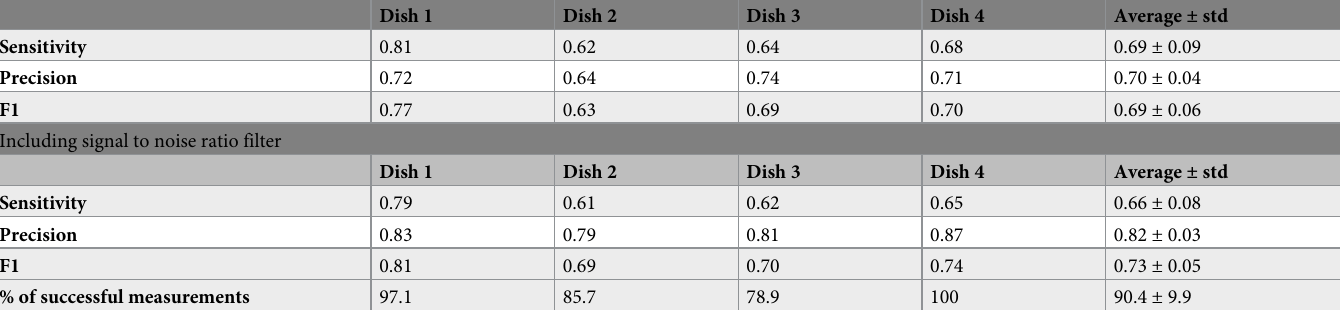
Table 1. Validation results before and after inclusion of the signal to noise ratio filter.